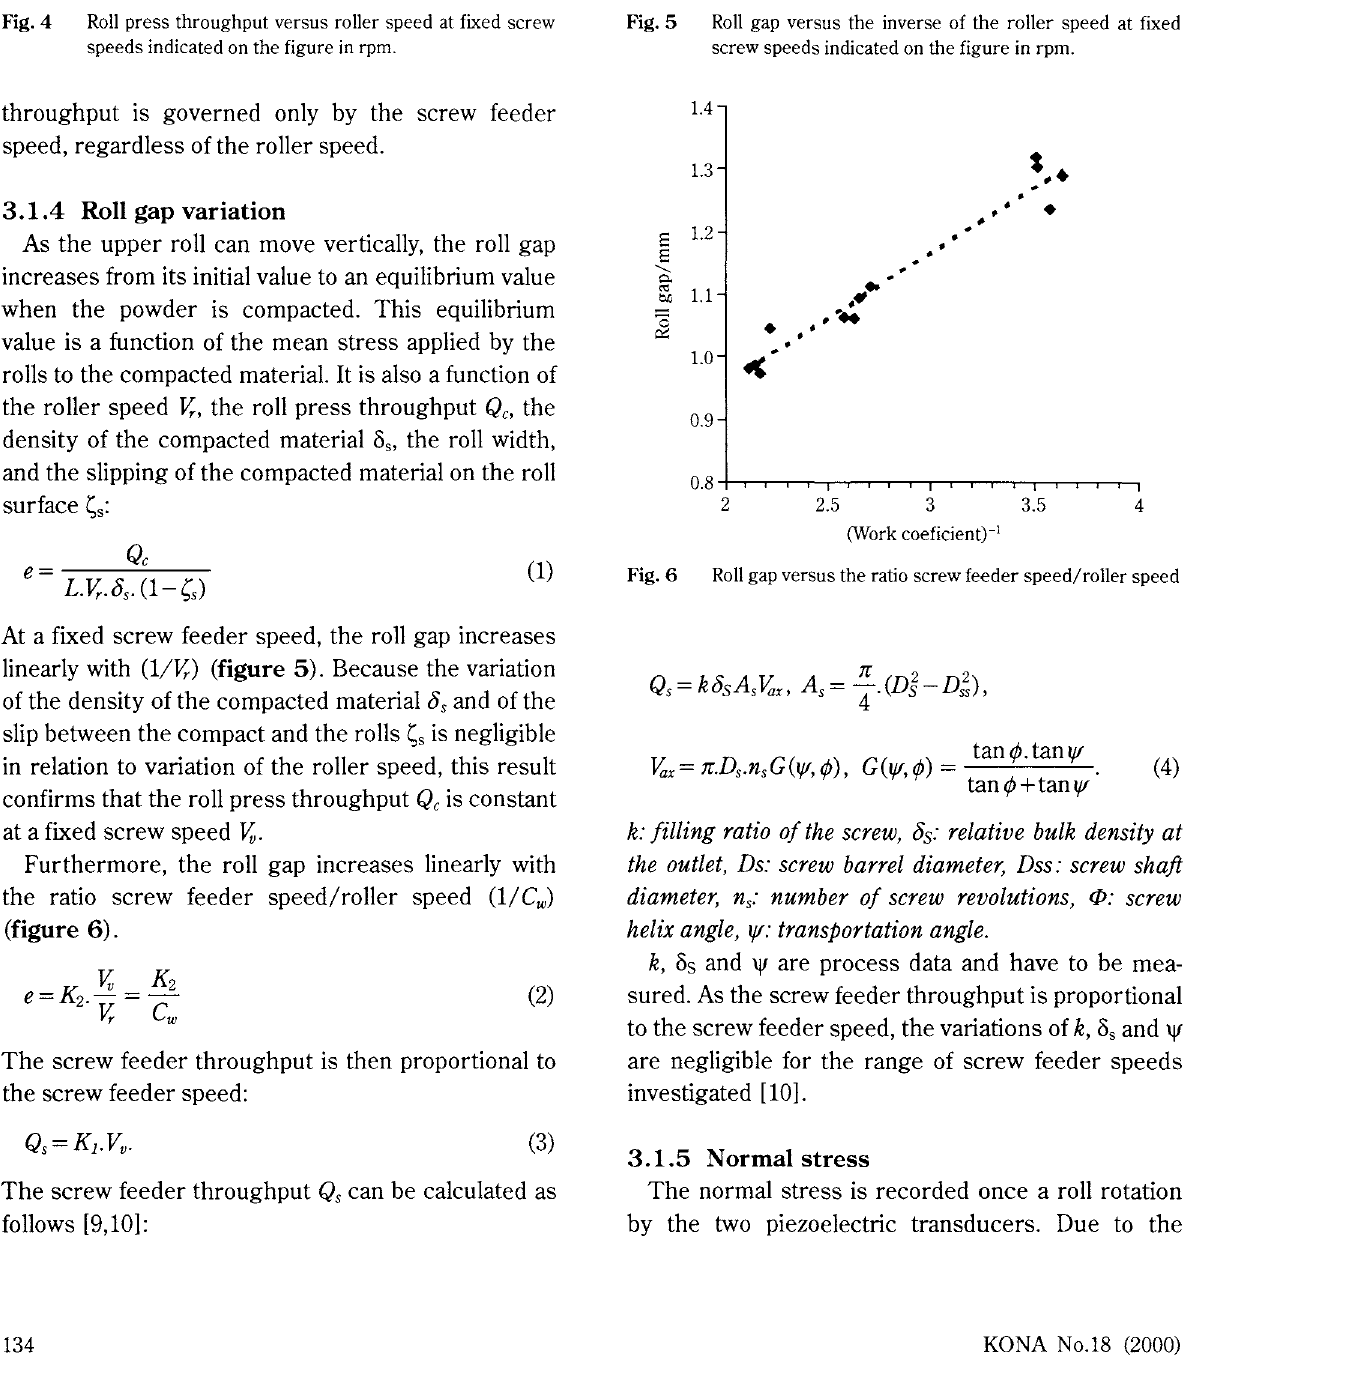
Roll press throughput versus roller speed at fixed screw speeds indicated on the figure in rpm.